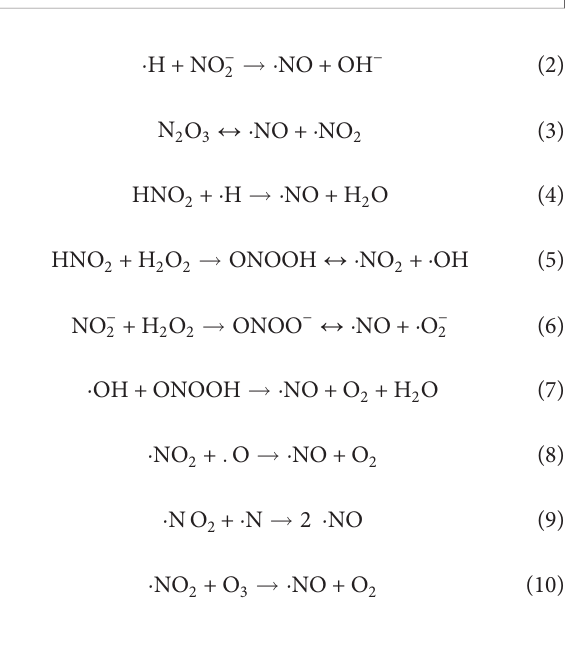
FIGURE 7 | DBD-CAP suppresses Hs578T (ER-, highly metastatic) breast cancer cell growth. (A , C , E) Assessment of % cell survival 24 h after treatment with mild (0.5 kHz/27.6 kV) or strong (1.5 kHz/27.6 kV or 0.5 kHz/31.2 kV) DBD-CAP (direct, indirect, media change) for 2 and 6 min. The values represent the mean ± SD of 3 (at least) independent experiments. Asterisks illustrate signi fi cant differences of the different treatment conditions compared to untreated (control) cells (* p < 0.05, ** p < 0.01, *** p < 0.001). (B , D , F) Cell morphology after mild (0.5 kHz/27.6 kV) or strong (0.5 kHz/31.2 kV) DBD-CAP treatment for 2 min. Scale bars, 50 µm. Representative immuno fl uorescence images are shown ( F-actin , green; nuclei ,